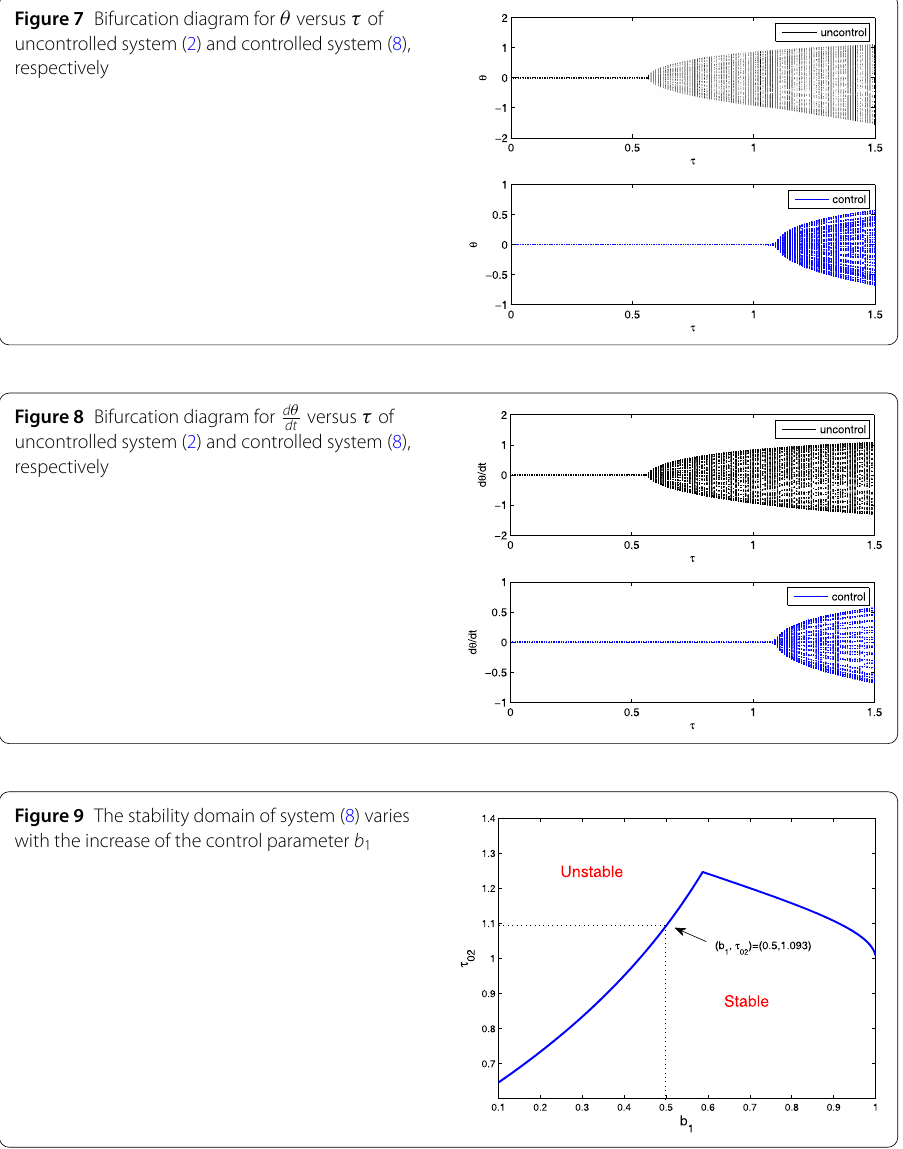
Figure 7 Bifurcation diagram for θ versus τ of uncontrolled system (2) and controlled system (8), respectively